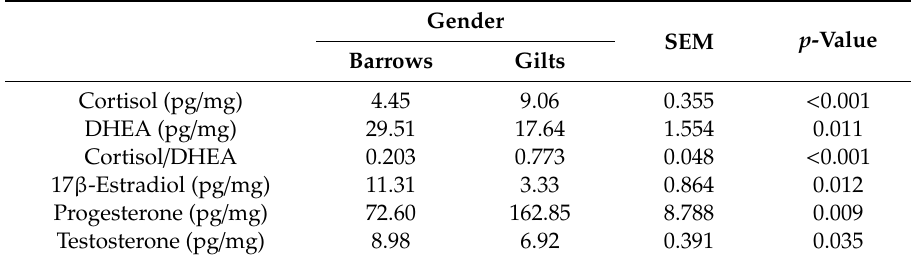
Table 1. Estimated marginal means of hair hormone concentrations and the cortisol / DHEA ratio recorded for barrows and gilts. Gender SEM p -Value Barrows Gilts Cortisol (pg / mg) 4.45 9.06 0.355 < 0.001 DHEA (pg / mg) 29.51 17.64 1.554 0.011 Cortisol / DHEA 0.203 0.773 0.048 <